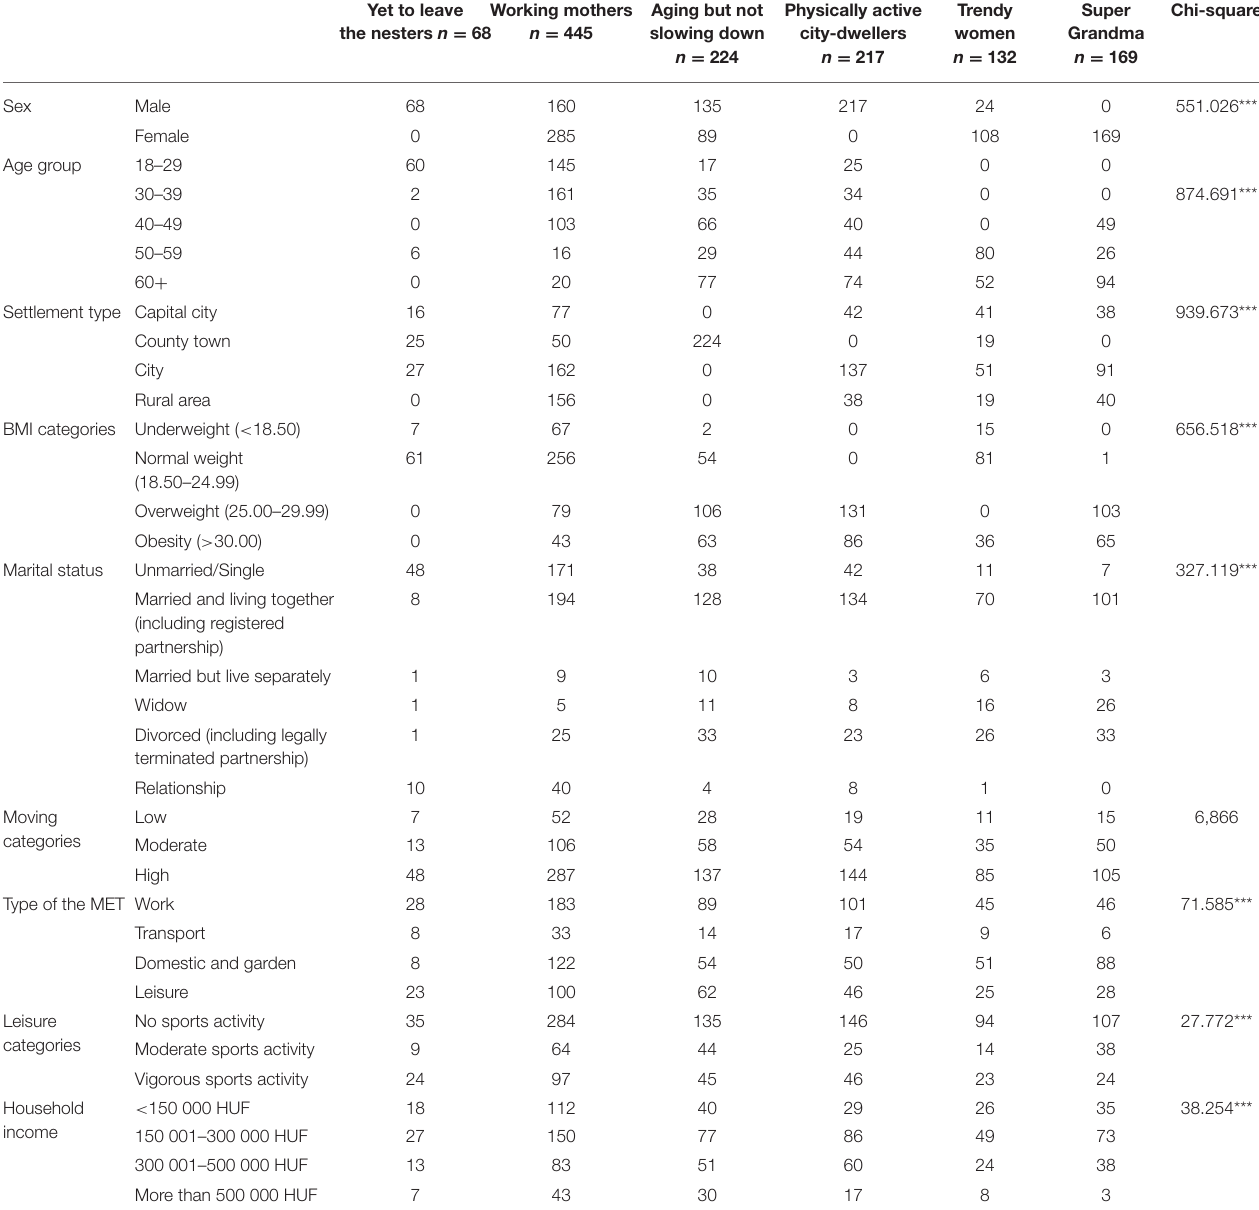
TABLE 5 | Difference in the six clusters on the basis of sex, age, place of residence, region, BMI index, family status, activity level, physical activity categories and leisure-time activity.